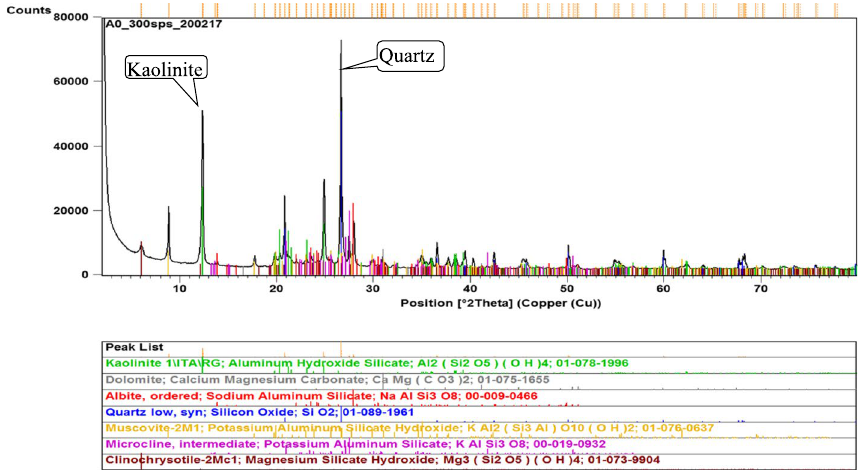
Fig. 6 Typical mineral composition of initial samples without lime/carbonate treatment, identified by X-ray diffraction